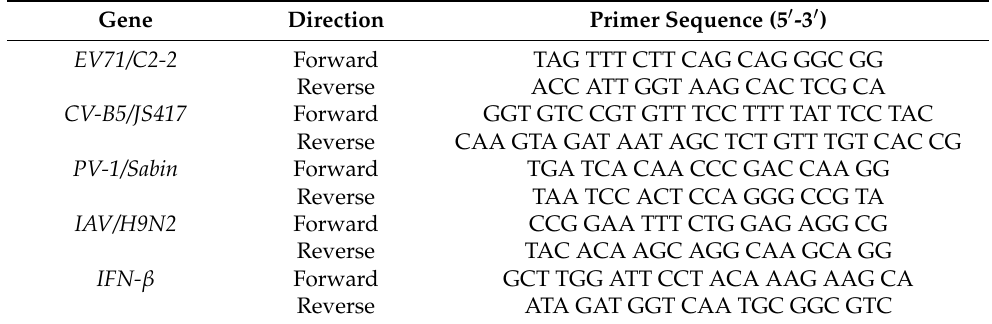
Table 2. Primer sequences used for RT-qPCR.